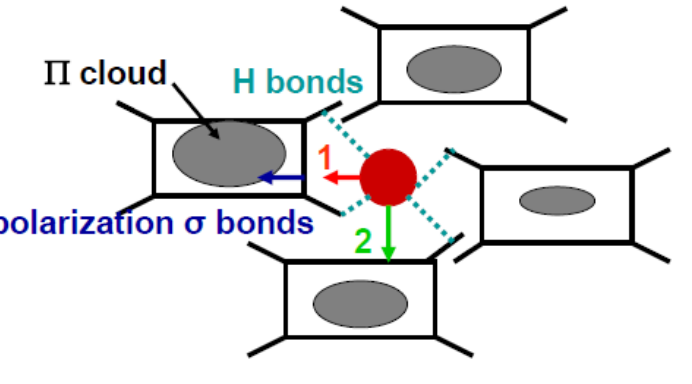
Figure 9. Schematic illustration of the two types of anion shifts. Process 1 (in red): displacement of the anion inside the methyl group cavity which polarizes the H-bond network and the σ electron skeleton of the TMTTF. Process 2 (in green): shift of the anion X towards the Se/S of a donor D establishing a short X-D contact distance. The modulation of the density of π holes is indicated for Process